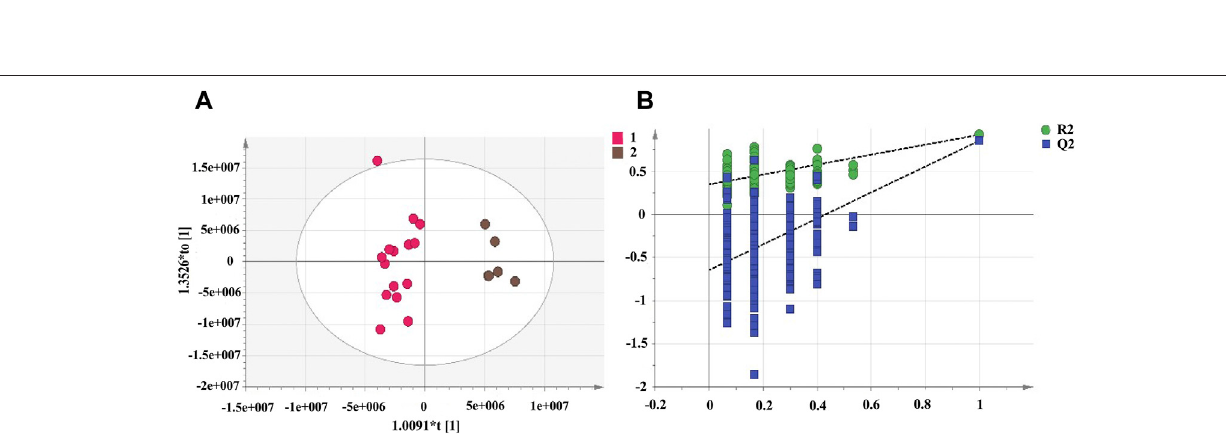
FIGURE 4 | Dendrograms of hierarchical cluster analysis (HCA) for samples of raw Reynoutria multi fl ora (RRM) and processed Reynoutria multi fl ora (PRM). (Group1: (F) : PRM 24 h, (G) : PRM 32 h; Group 2: (A) : RRM, (B) : PRM 4 h, (C) : PRM 8 h, (D) : PRM 12 h, (E) : PRM 18 h).